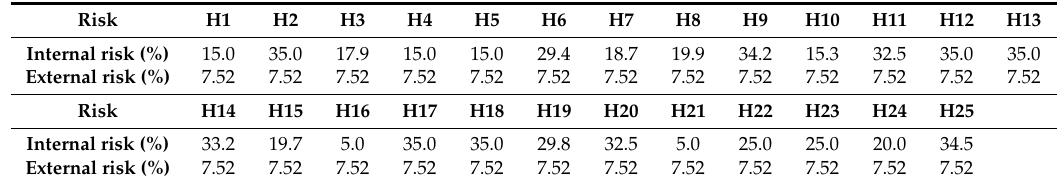
Table 10. Comparison of the overall internal and external